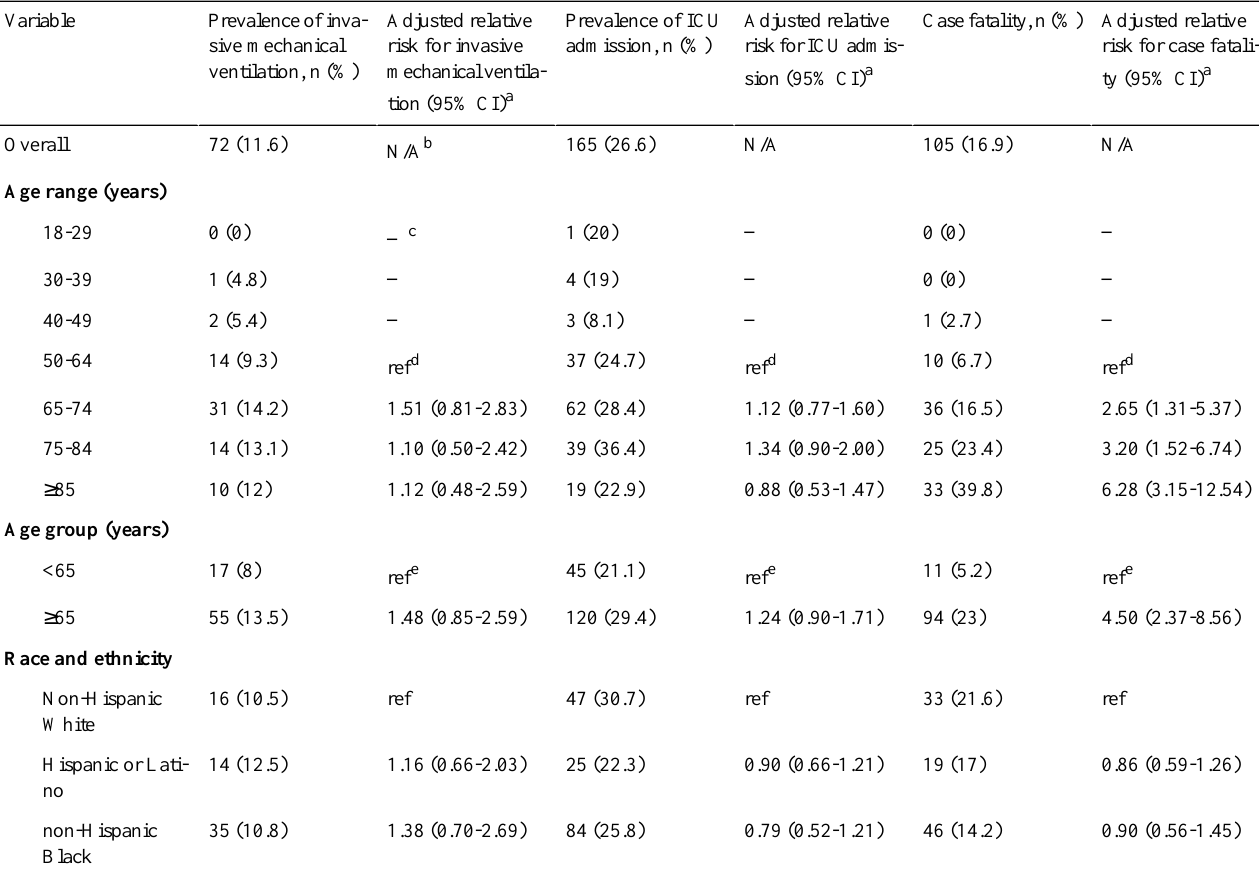
Table 2. Prevalence and adjusted relative risk of invasive mechanical ventilation, intensive care unit (ICU) admission, and deaths among US veterans hospitalized with COVID-19—overall, by age, and by race and ethnicity, at 5 Veterans Affairs Medical Centers from February 27 to July 17,